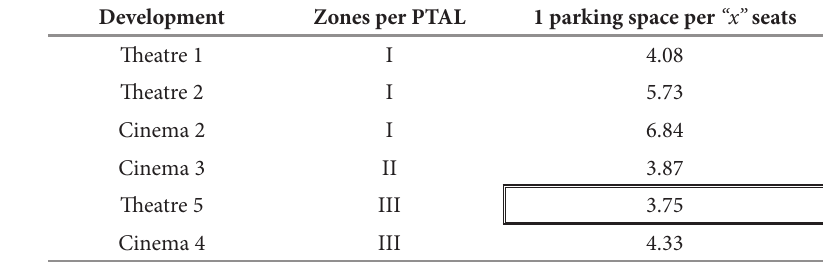
Table 7. Definition of basic standard